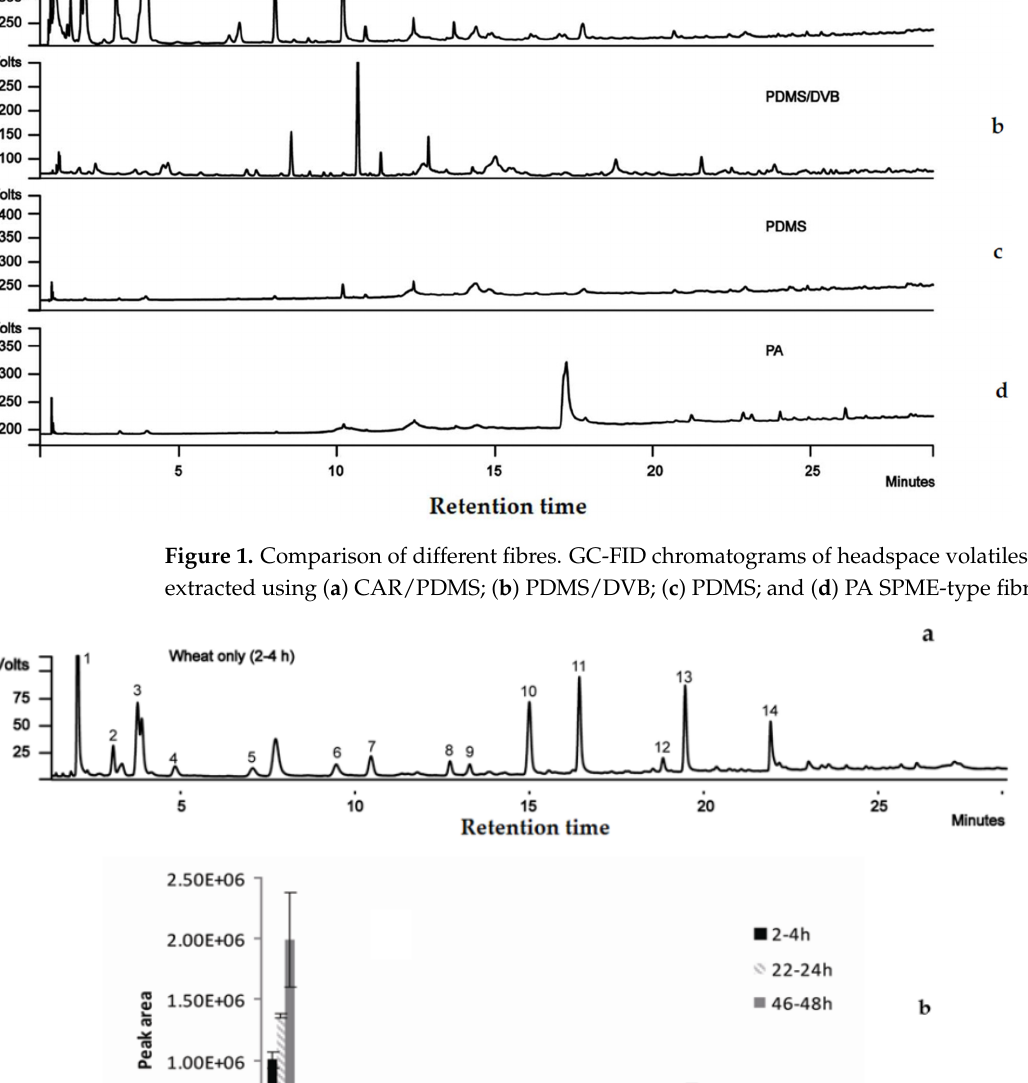
Table 1. The seven treatments used in GC, GC/MS analysis.